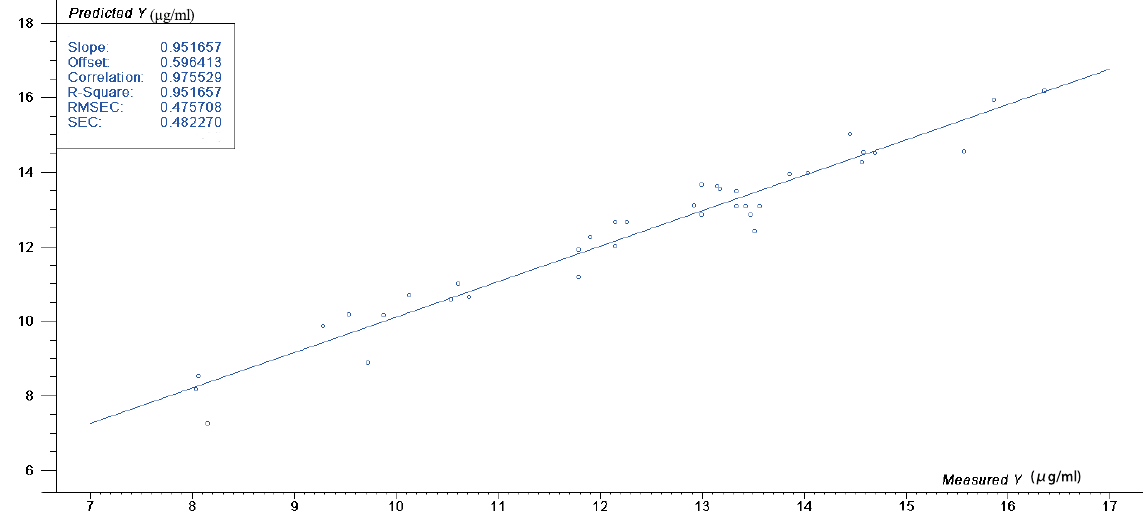
Fig. 4. Predicted and measured values of tannin in injection samples.